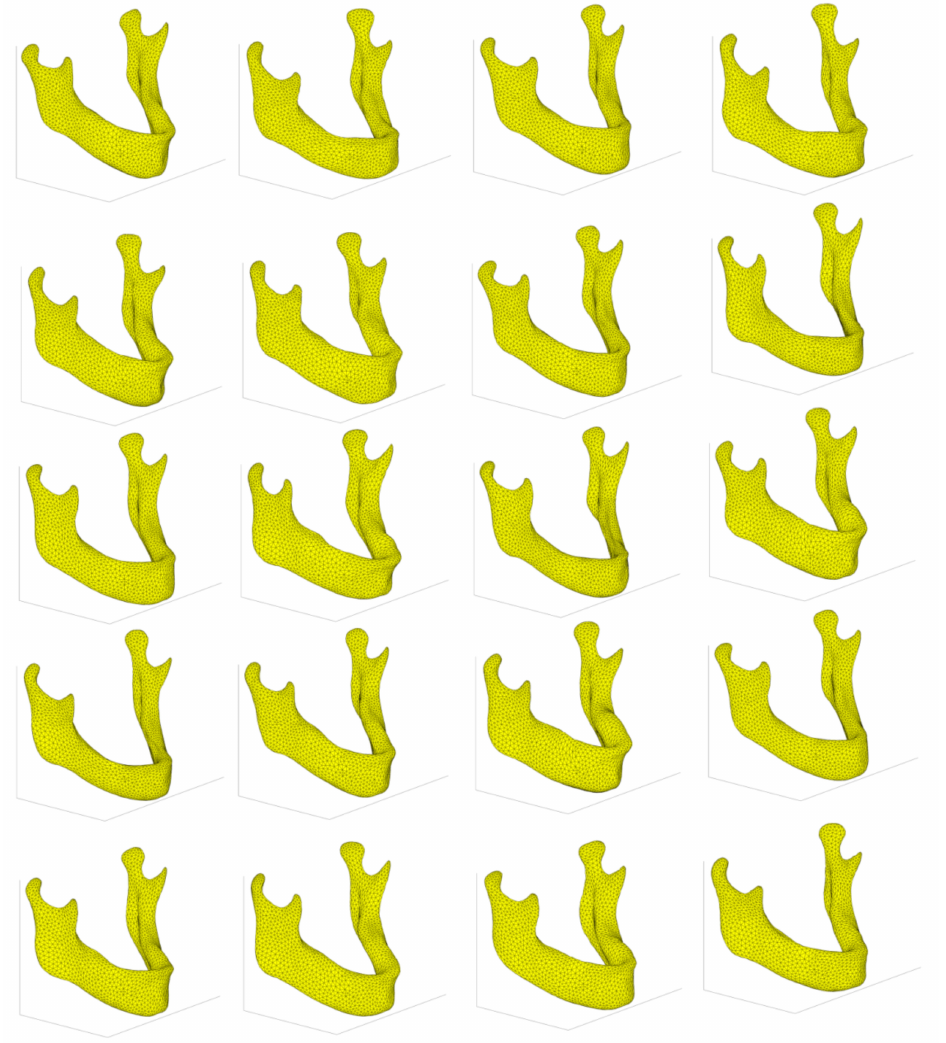
Figure 6. New set of 20 mandibles, generated through inverse transform sampling, applied on empirical cumulative weight distribution of weights for each